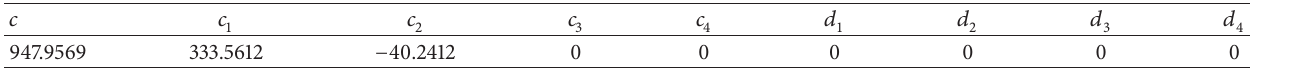
Table 2: Estimation of the parameters.